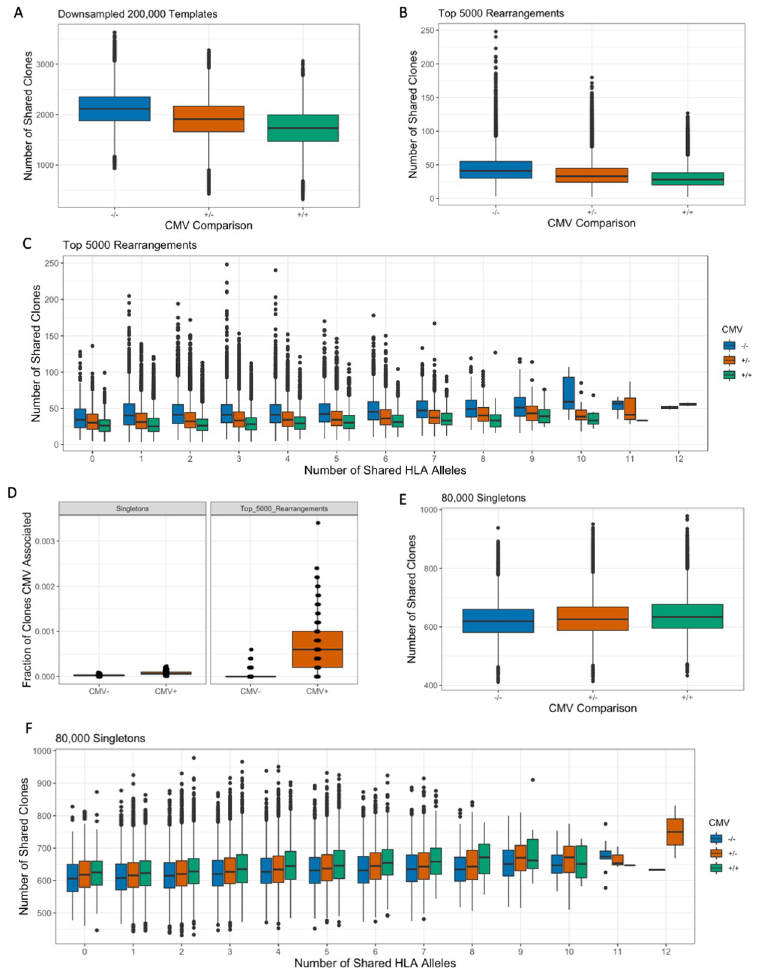
Fig 4. CMV status influences TCR β clone sharing. (A) CMV- individuals shared more TCR β clones within their down-sampled repertoires compared to CMV+ individuals. (B) CMV- individuals shared more of their top 5,000 rearrangements compared to CMV+ individuals. (C) CMV- individuals shared more top rearrangements than CMV + individuals do, regardless of the number of HLA alleles shared. (D) There was a greater fraction of clones in CMV + individuals that were among the 164 CMV associated clones identified in Emerson et al. [11] compared to CMV- individuals, among both singletons and top 5,000 rearrangements (Wilcoxon rank sum tests, p < 2.2e-16 for both). (E) There was a similar number of singletons shared among CMV- and CMV+ individuals. (F) CMV+ individuals with a common number of shared HLA alleles shared slightly more singletons than CMV- individuals do.